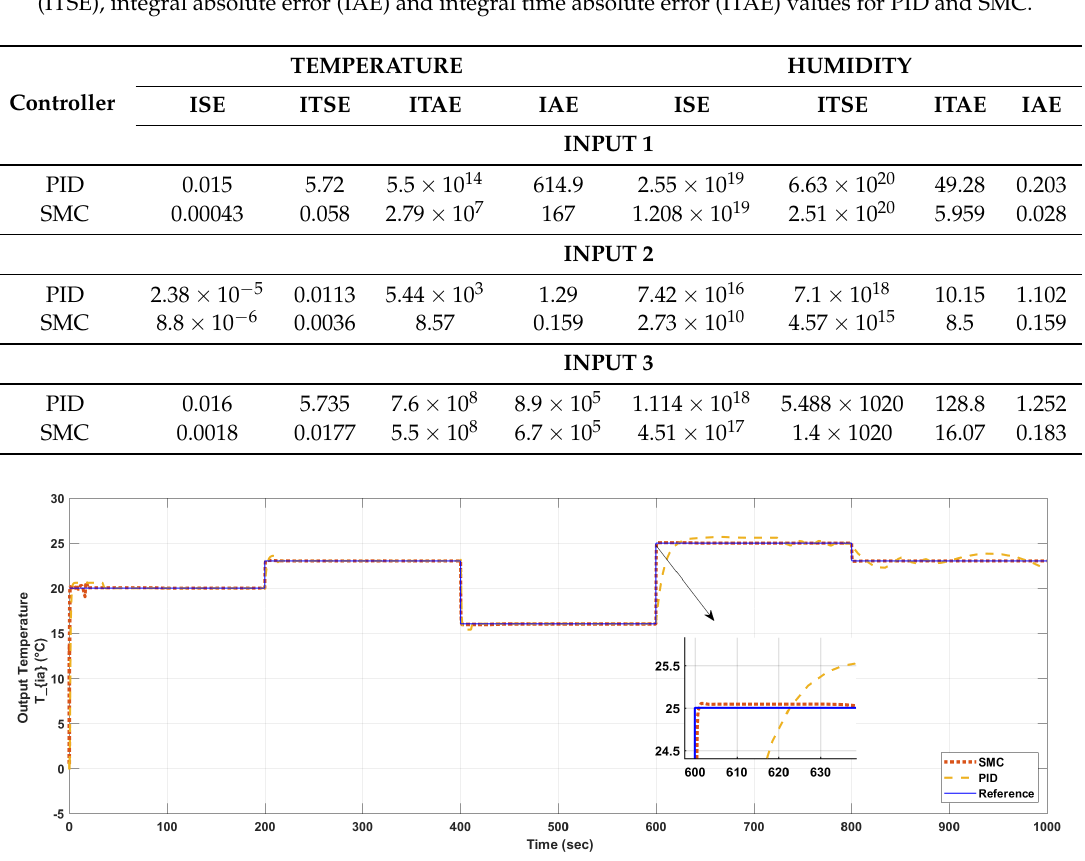
Figure 5. Output temperature response of controllers while tracking sequence of steps